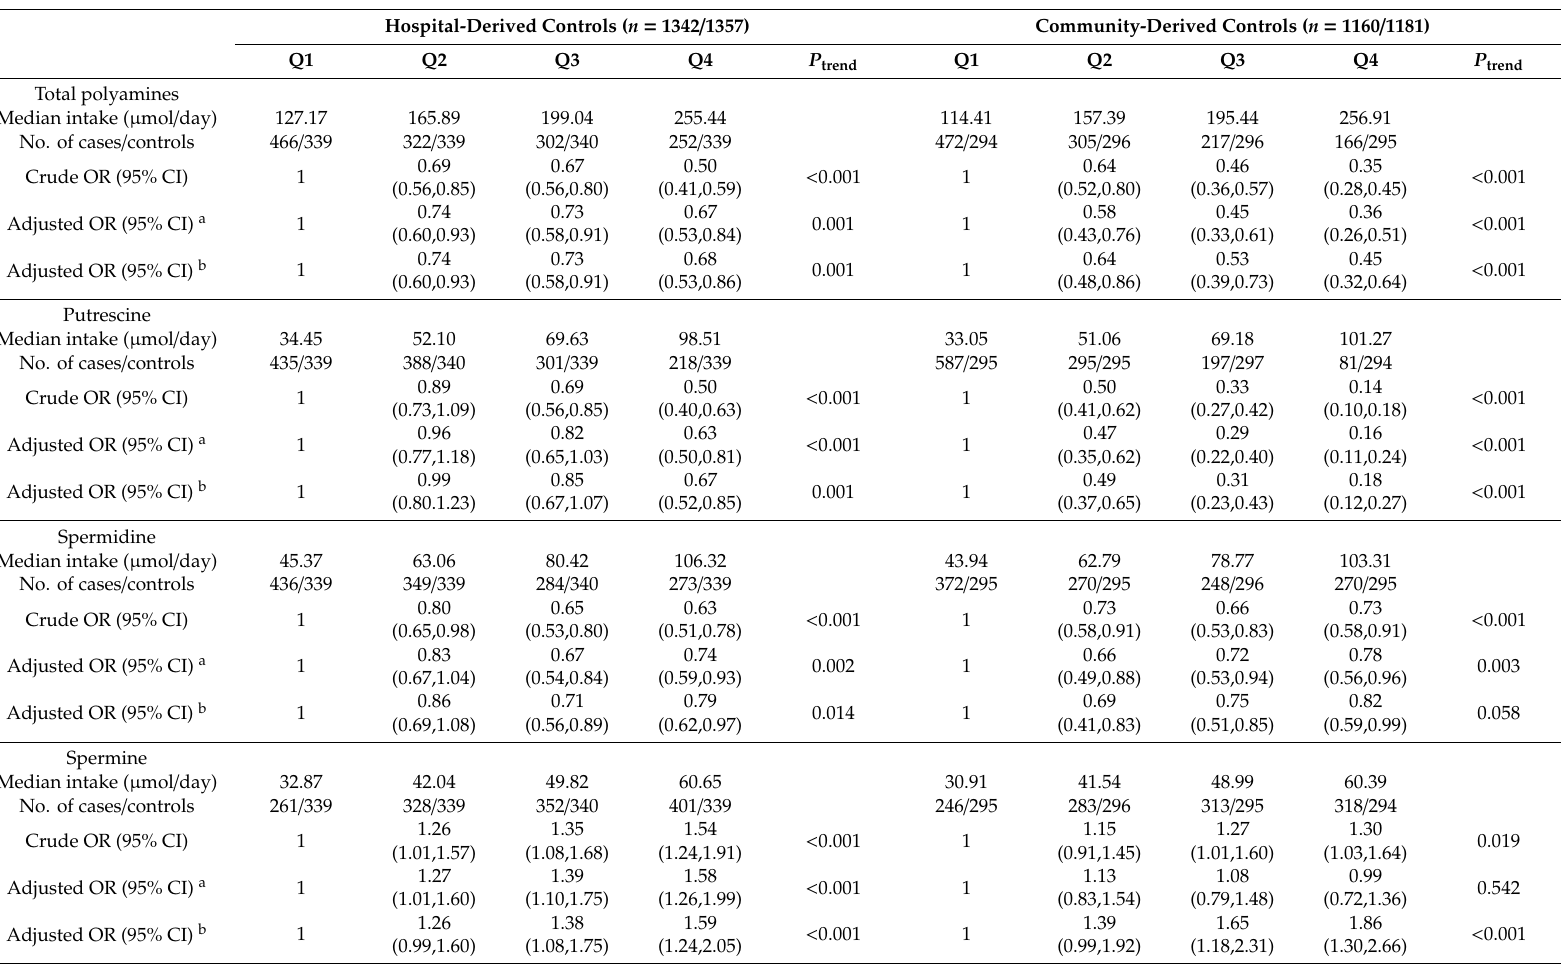
Table 6. Associations between polyamines intakes and colorectal cancer risk by di ff erent sources of controls (Odds ratios and 95% confidence intervals). Hospital-Derived Controls ( n = 1342 /